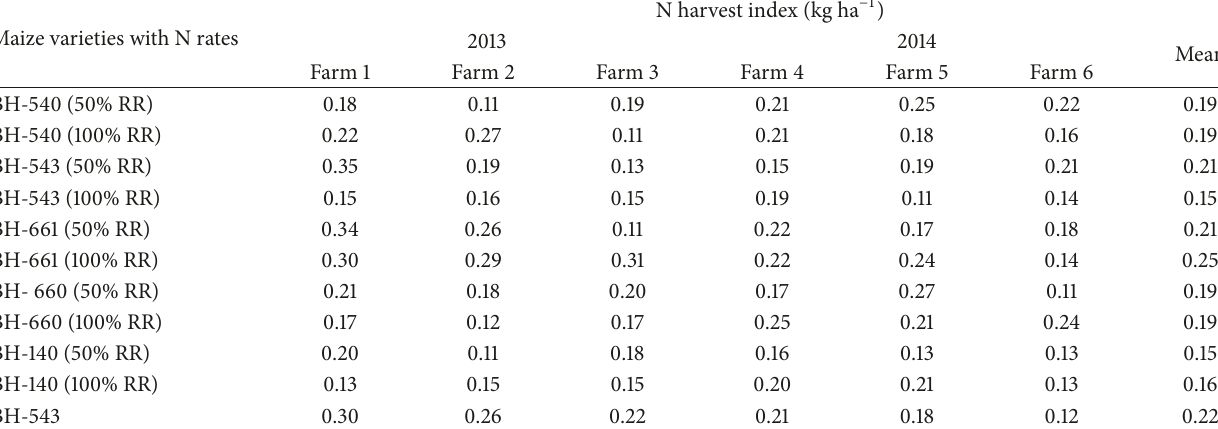
Table 8: Effects of varieties and nitrogen rate on N harvest index of maize on farmer’s field around Bako Tibe, western Ethiopia. Maize varieties with N